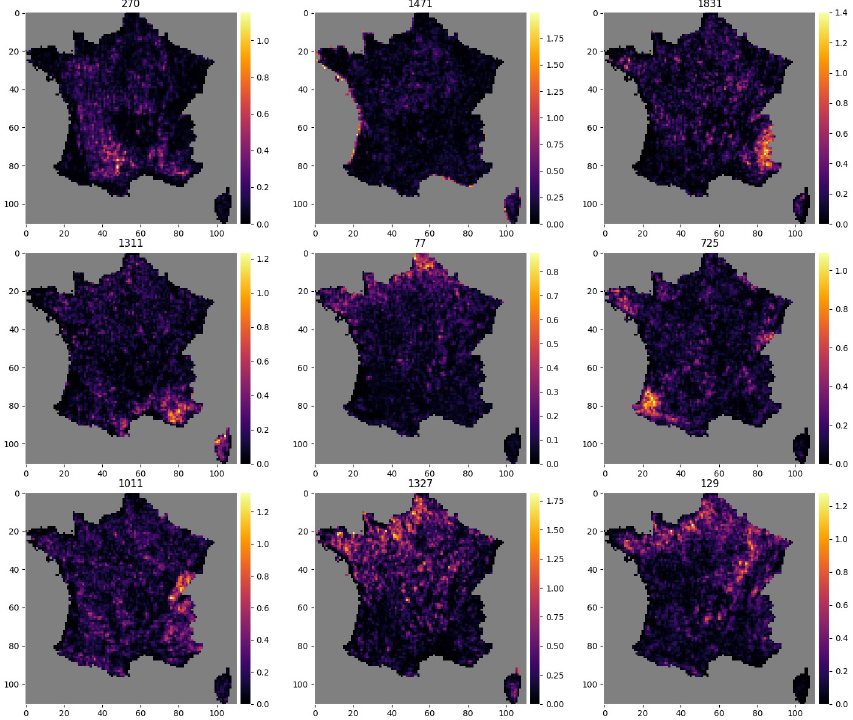
Fig 10. Activations maps highlighting large scale geographical shapes. Example of 9 activation maps, for 9 different neurons, among the 2048 neurons of the final layer of the CNN-SDM that shows large scale geographical shapes. The number of the neuron is indicated above each